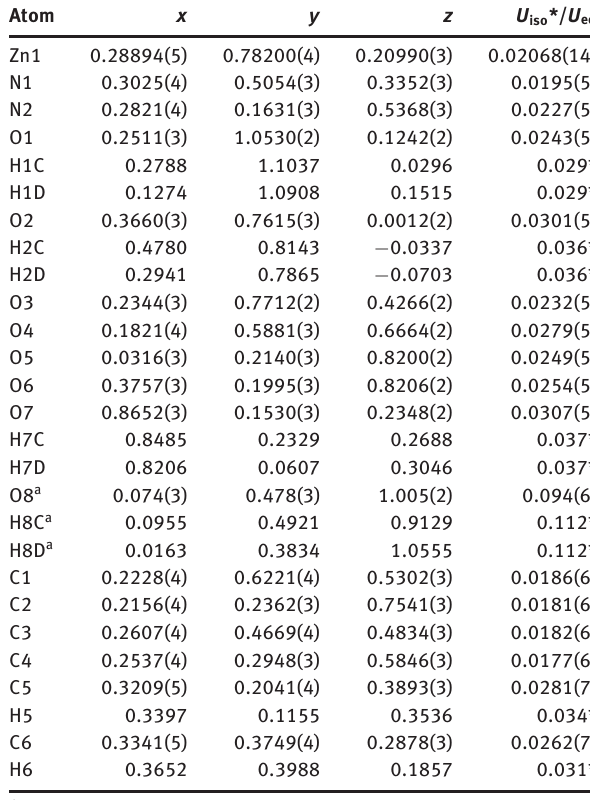
atomic coordinates and displacement parameters.